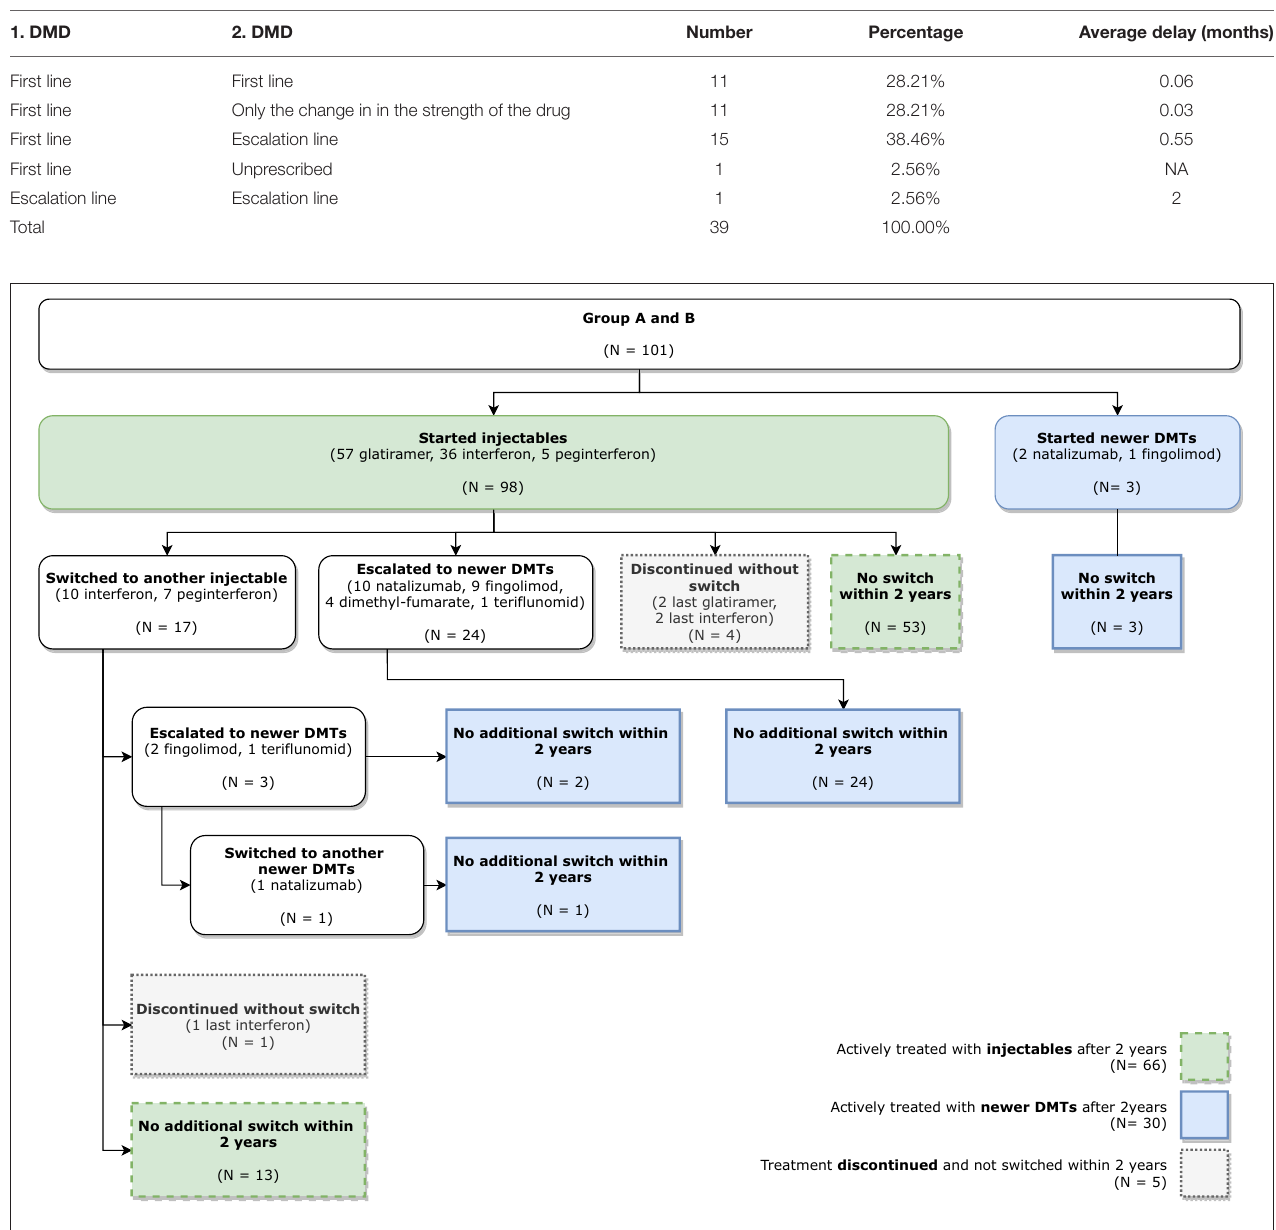
TABLE 5 | Summary of changes in the treatment lines in patients who have completed their first DMD treatment.